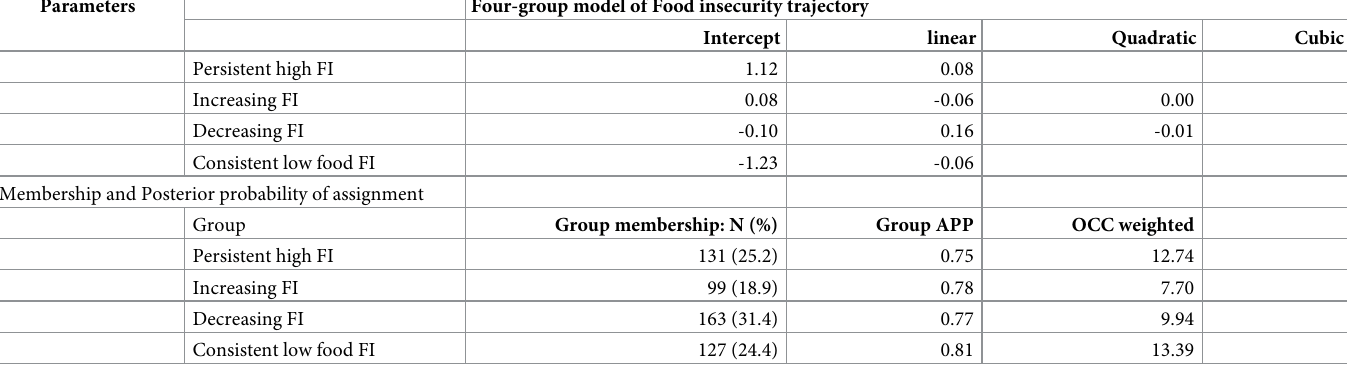
APP = Average of the maximum posterior probability of assignments. OCC = Odds of correct classification weighted posterior